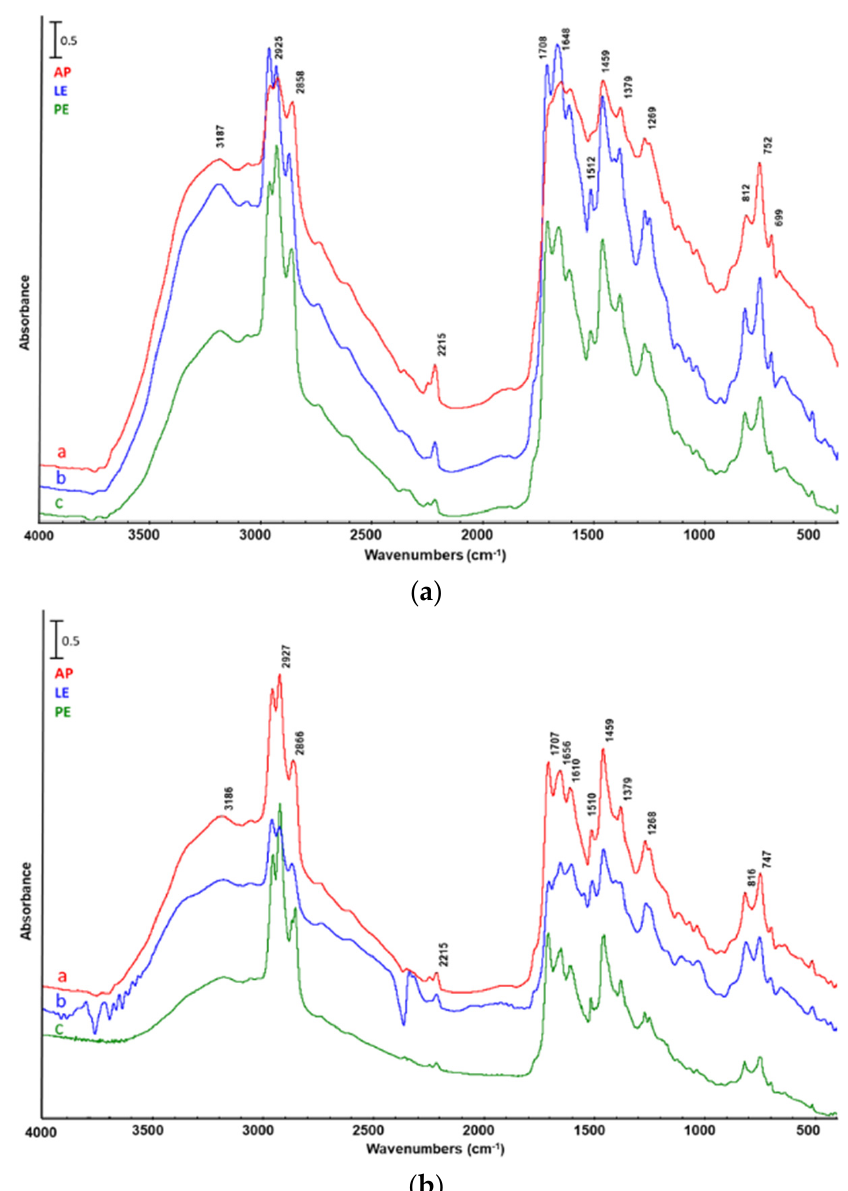
Figure 8. FTIR analysis of liquid residue from catalytic pyrolysis of a— Arthrospira platensis untreated biomass (AP), b—biomass after lipid extraction (LE), and c—biomass after protein extraction (PE). Catalyst: ( a ) ZSM5, ( b ) silica–alumina.